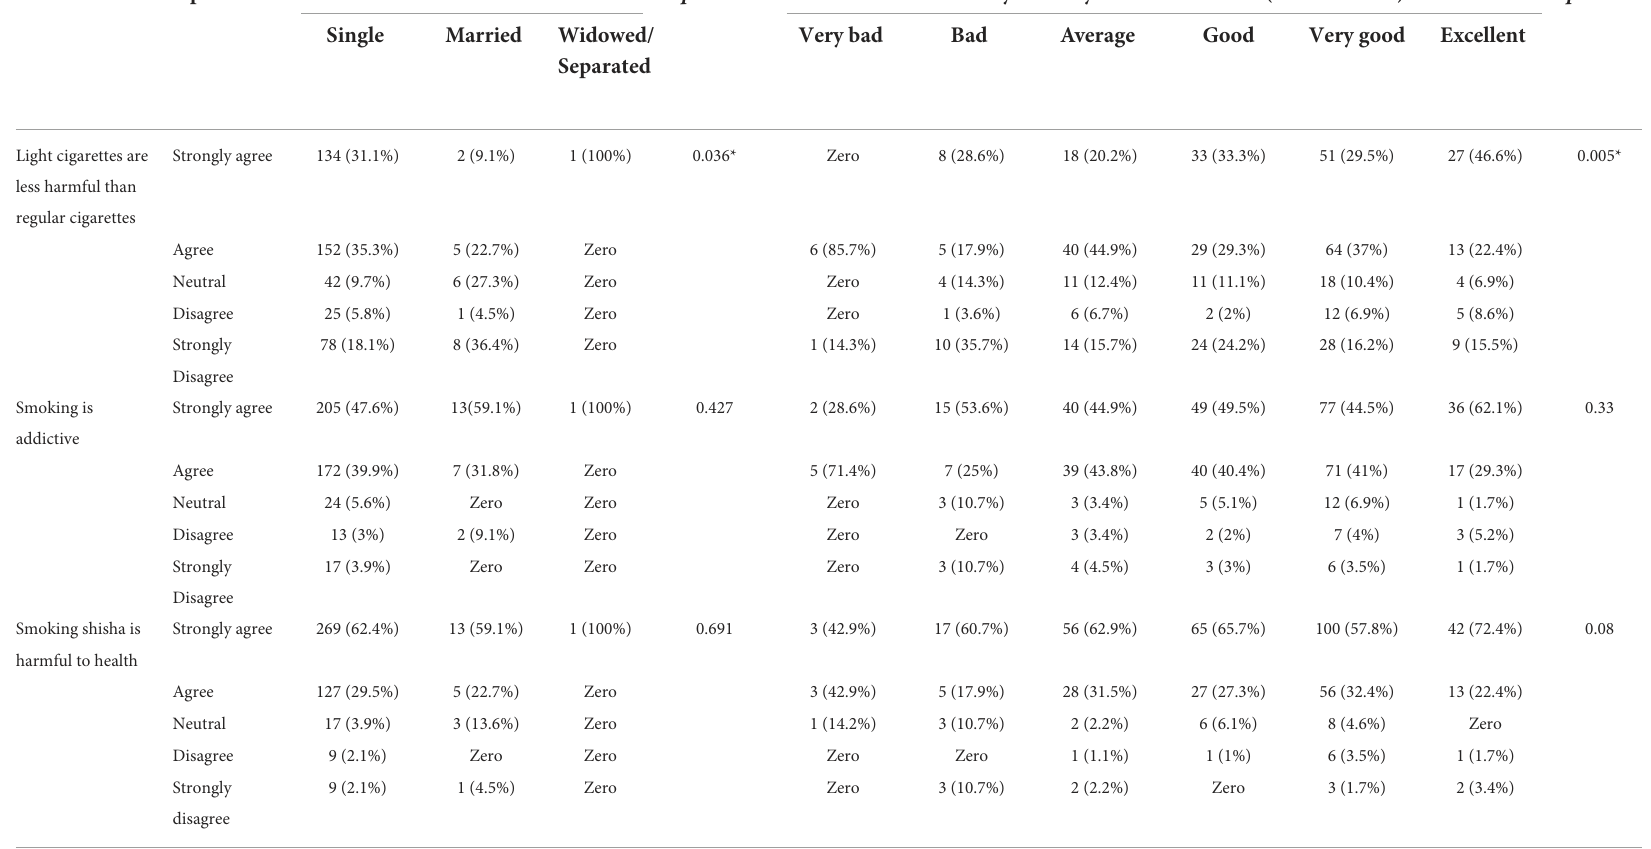
TABLE 7 Opinion regarding the harmful effects of